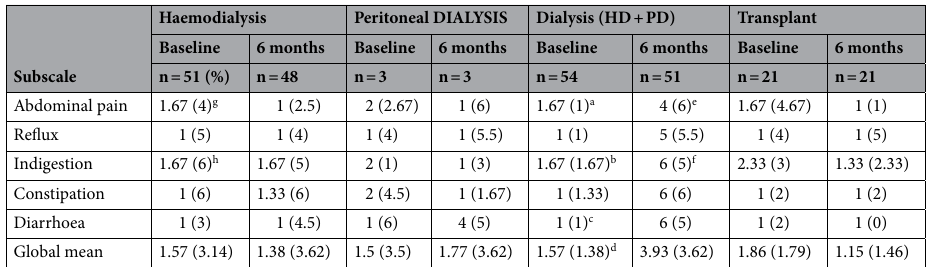
Table 3. GSRS scores per treatment group at baseline and 6 month follow-up. GSRS scores. a Significantly higher for females (mean rank = 32.66) than males (mean rank = 23.95), p = .040. b Significantly higher for females (mean rank = 34.00) than males (mean rank = 23.03), p = .011. c Significantly higher for females (mean rank = 32.27) than males (mean rank = 22.22), p = .022. d Significantly higher for females (mean rank = 33.09) than males (mean rank = 23.66), p = .030. e Significantly higher for females (mean rank = 30.85) than males (mean rank = 22.87), p = .025. f Significantly higher for females (mean rank = 31.83) than males (mean rank = 22.24), p = .020. g Significantly higher for females (mean rank = 30.83) than males (mean rank = 22.62), p = .045. h Significantly higher for females (mean rank = 31.93) than males (mean rank = 21.85), p = .016.